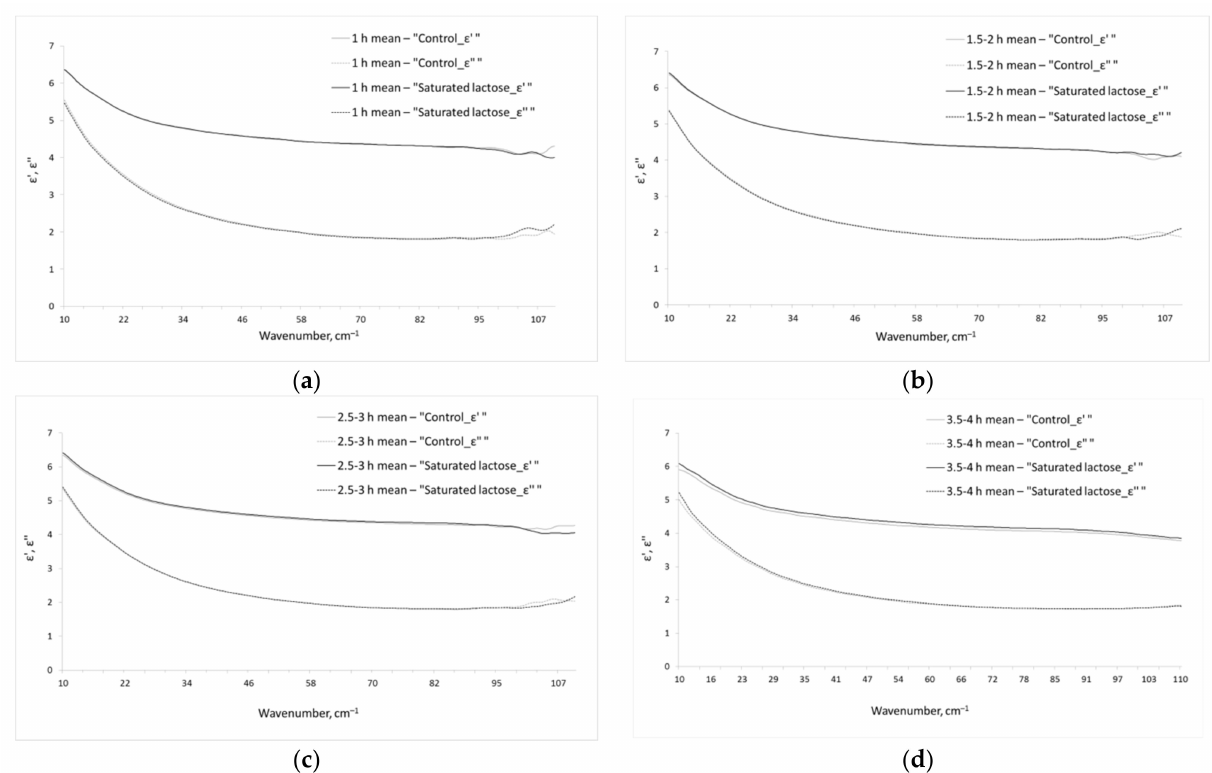
Figure 1. Dielectric permittivities (real ε (cid:48) and imaginary ε (cid:48)(cid:48) parts) of the aqueous phase of the studied IFN γ solutions. The total incubation times of IFN γ solutions in the saturated lactose (black line ( ε (cid:48) ) or dashes ( ε (cid:48)(cid:48) )) and control (gray ( ε (cid:48) ) or dashes ( ε (cid:48)(cid:48) )) environment are 1 h ( a ), 1.5–2 h ( b ), 2.5–3 h ( c ), 3.5–4 h ( d ).